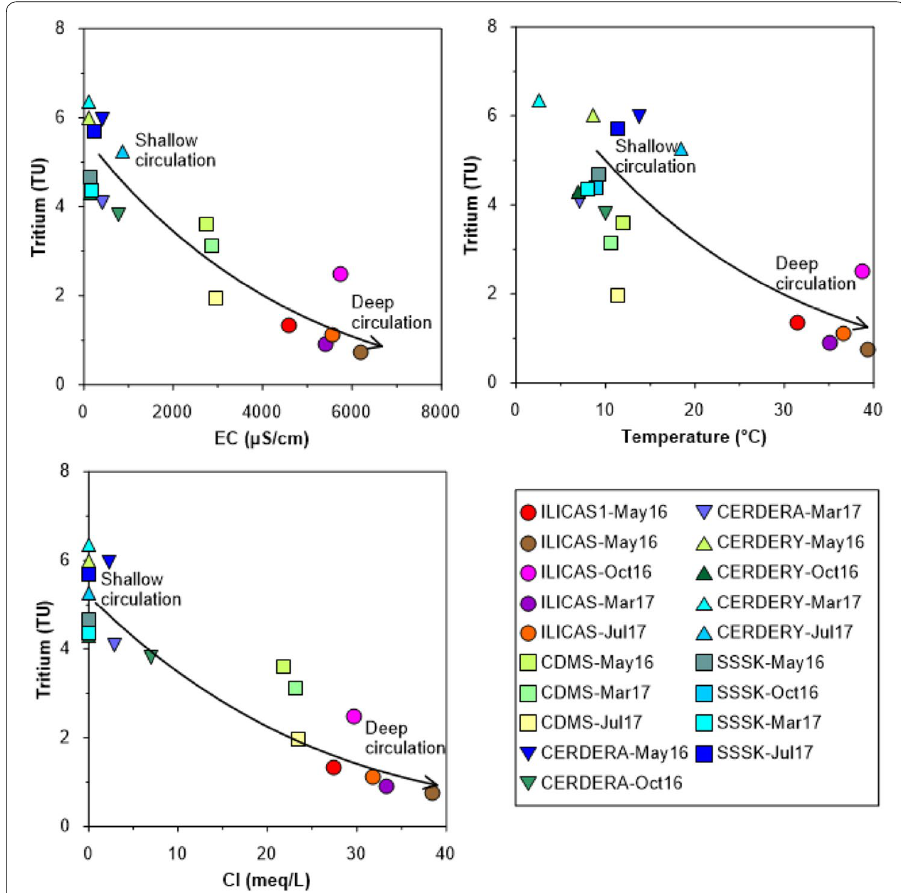
Fig. 14 3 H–EC, 3 H–Cl − , and 3 H–T (°C) relations for waters in the study